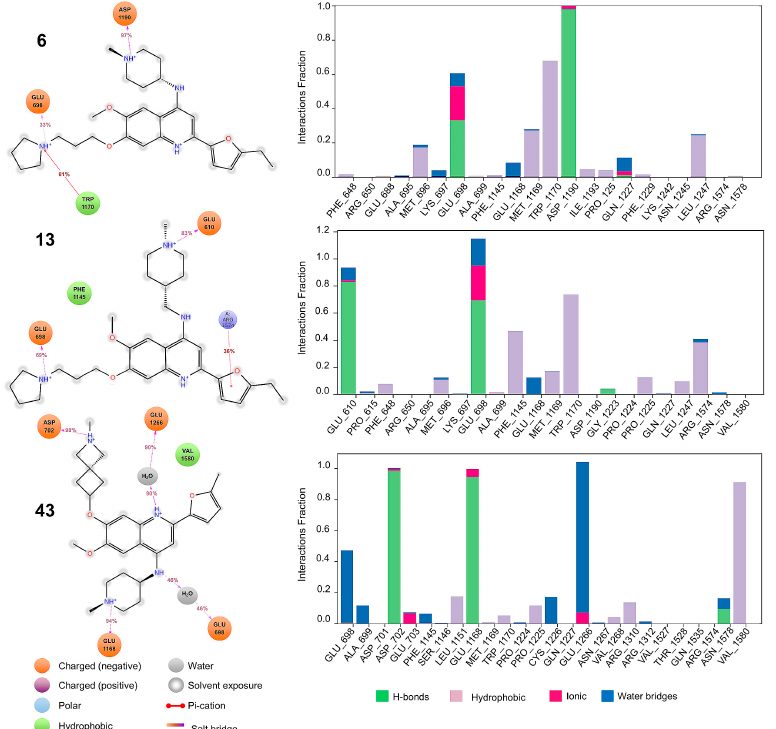
Figure 11. DNMT1–ligand contact analysis during the 100 ‐ ns simulations. The diagrams show the fraction and type of interactions with representative ligands during the